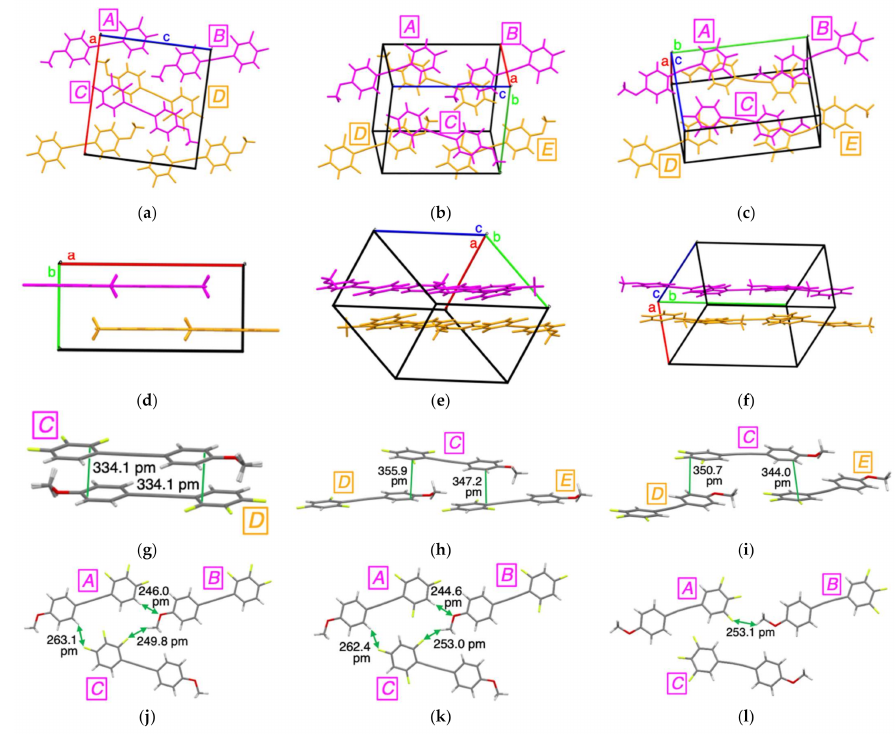
Figure 5. Crystal structure of ( a , d ) 3Fa , ( b , e ) 3Fb, and ( c , f ) 3Fc . Intermolecular interactions in ( g , j ) 3Fa , ( h , k ) 3Fb, and ( i , l ) 3Fc .